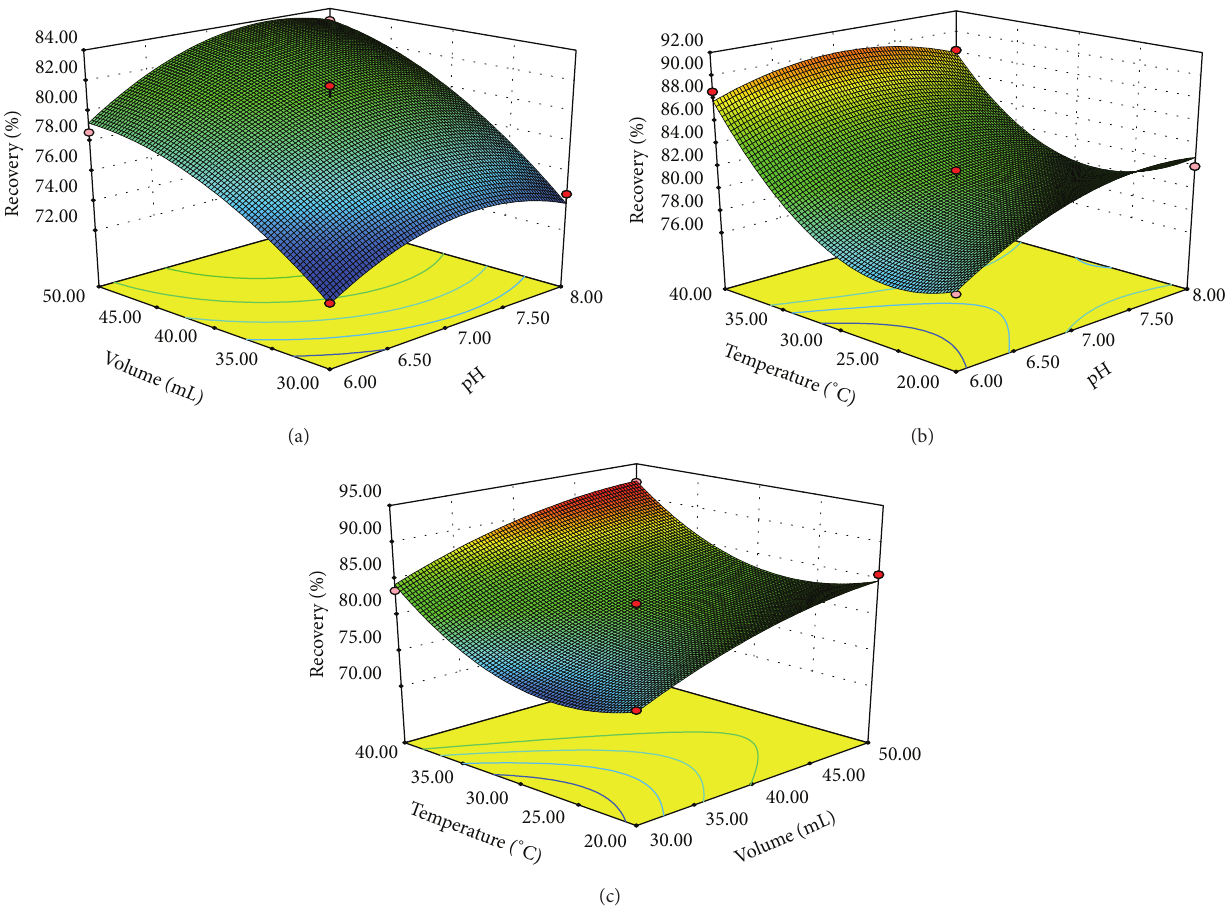
Figure 3: Response surfaces using the Box-Behnken design obtained by plotting: (a) solution pH versus solution volume (extraction temperature: 30 ∘ C), (b) solution pH versus extraction temperature (solution volume: 40mL), and (c) solution volume versus extraction temperature (solution pH: